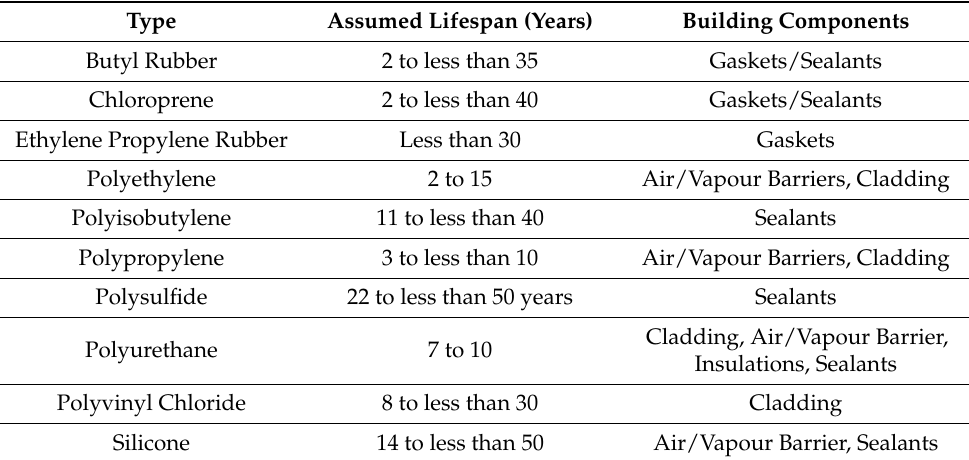
Table 1. Assumed lifespan of some plastics; Adapted from Ref.